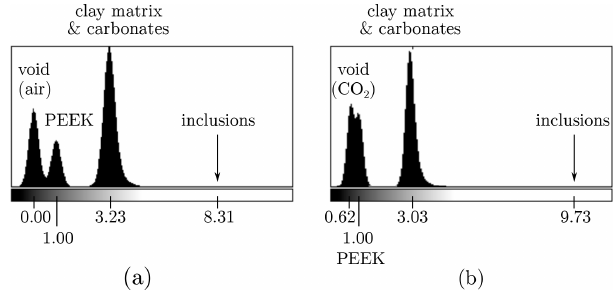
Figure A2. Grey value histogram of normalised (a) scan 00 (no CO 2 ) and (b) scan 01 (with CO 2